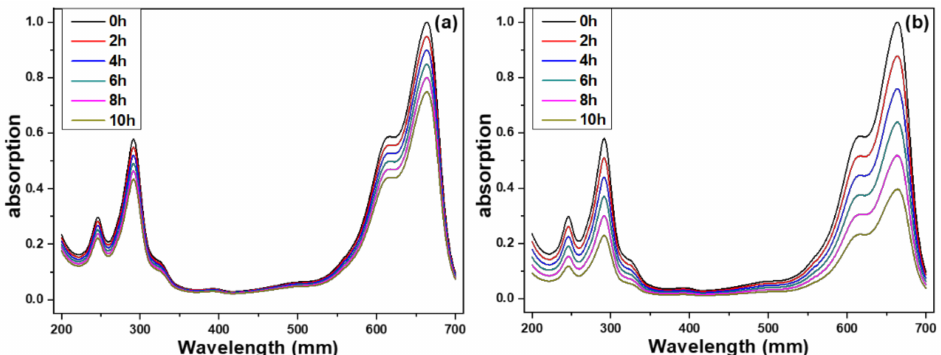
Figure 9. Ultraviolet–visible spectra of treated methylene blue solution under different irradiation time of UV light and different synthesis times of ZnO NFAs, ( a ) 20 min and ( b ) 60